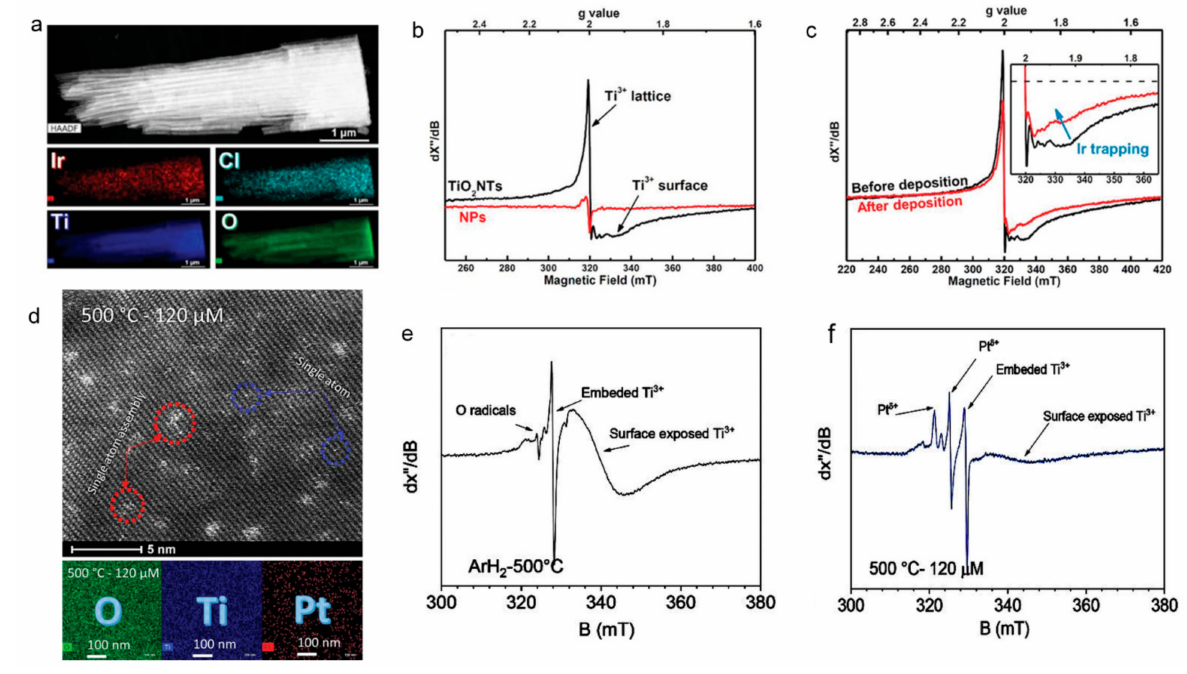
Figure 6. ( a ) TEM-EDX element mapping of TiO 2 nanotubes immersed in IrCl 3 solution for 24 h. ( b ) EPR spectra of stress-engineered TiO 2 NTs and anatase NPs, ( c ) EPR spectra of TiO 2 NTs before and after dark deposition of Ir SAs. (The inset shows the plots from ≈ 315–365 mT at higher magnification). Adopted with permission from Ref. [134]. ( d ) HAADF-TEM image and EDS map of Pt-SA-decorated TiO 2 layer. ( e ) EPR spectra of TiO 2 anatase annealed at 500 ◦ C in Ar/H 2 . ( f ) EPR spectra of the layer after immersion in the 120 µ m hexachloroplatinic acid solution. Adopted with permission from Ref.